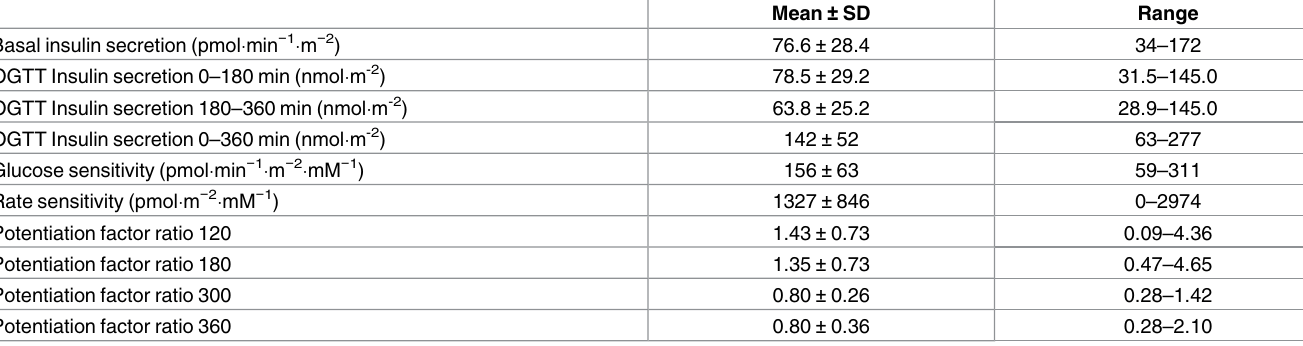
Table 2. Insulin secretion and β -cell function